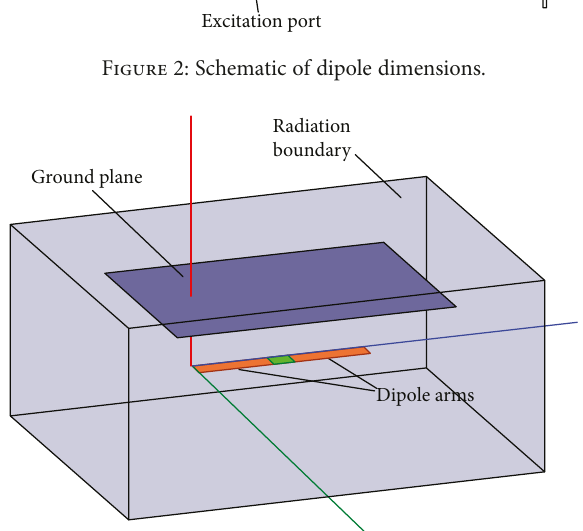
Figure 3: A simulation setup for the dipole antenna with a ground